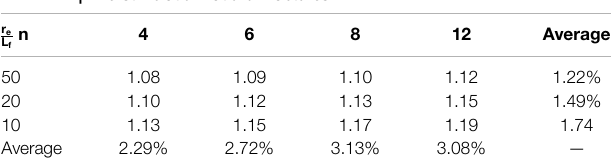
TABLE 2 | The stimulation ratio of